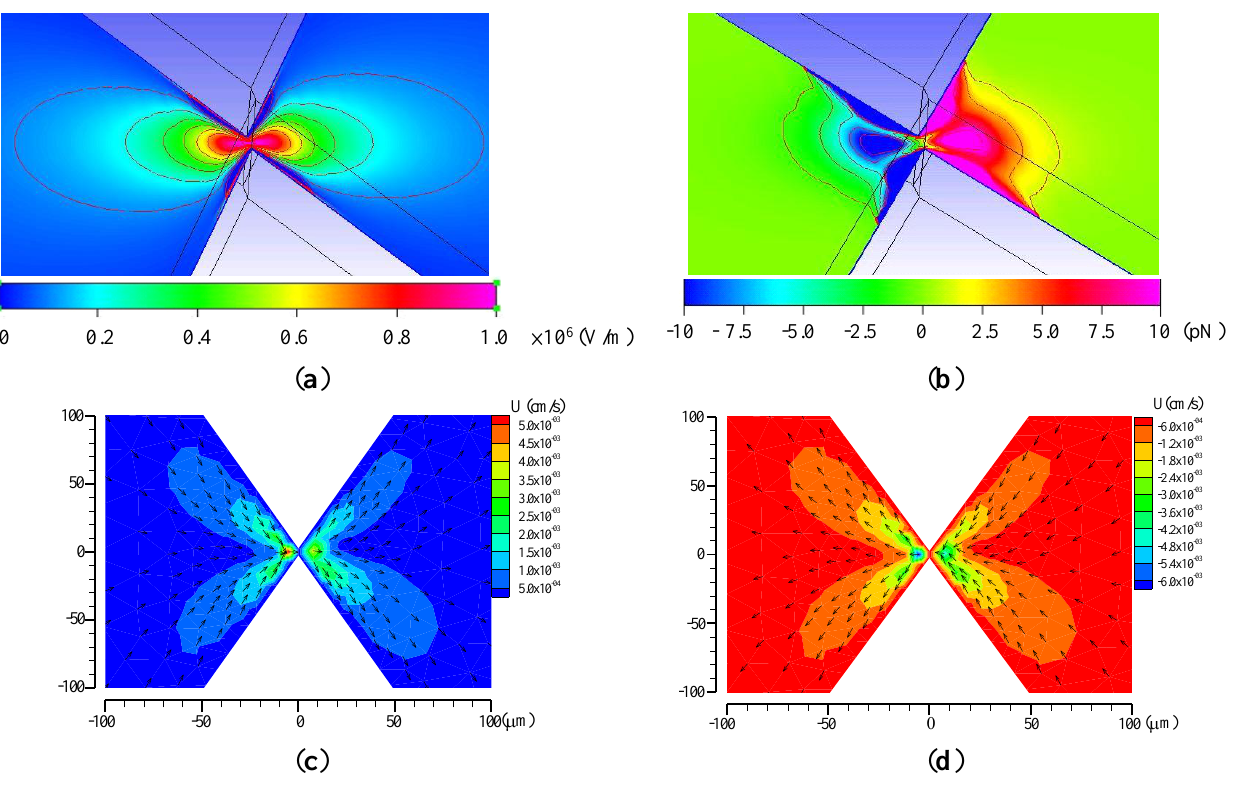
and ( b ) DEP force at the applied field of x